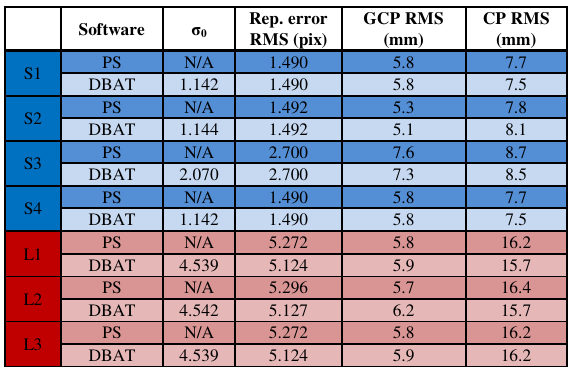
Table 3. Results for the different scenarios, showing the σ 0 , reprojection error RMS, GCP error RMS, and CP error RMS